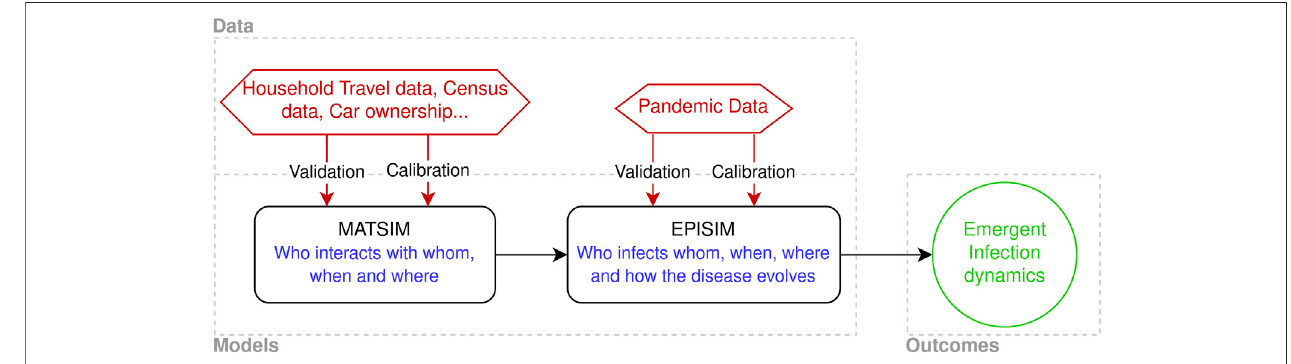
FIGURE 1 | Integrated simulation